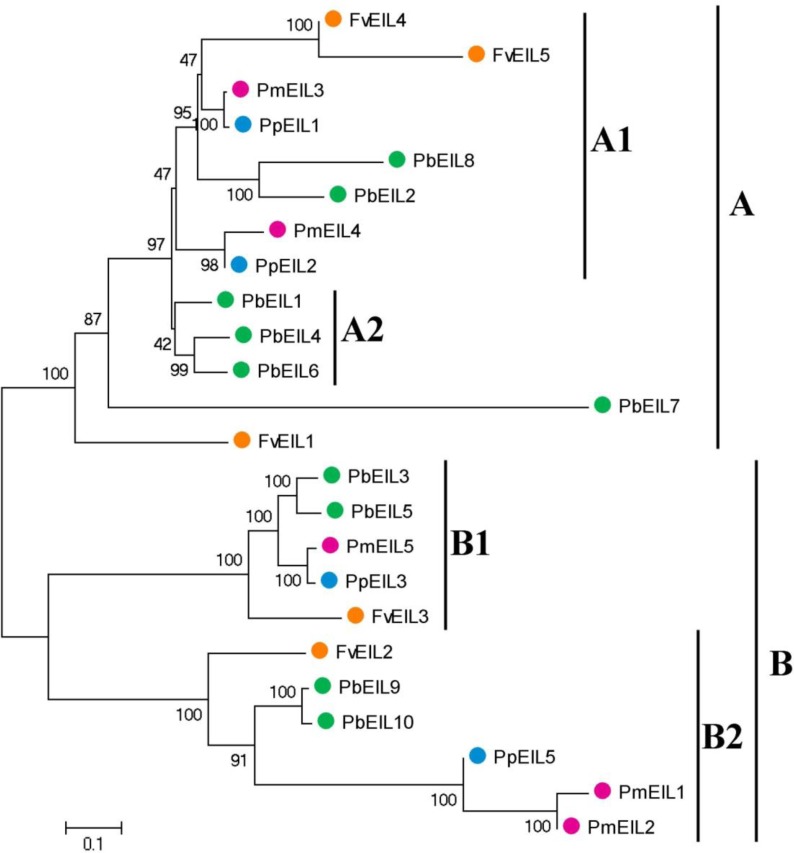
Phylogenetic tree of EIN3/EIL proteins from pear, peach, mei and strawberry.The neighbor-joining (NJ) tree was constructed by using MEGA 5 software. The neighbor-joining (NJ) tree was constructed by using MEGA 5 software (1,000 bootstrap replicates). The different colors suggest the different species background for each EIN3/EIL protein. Gene names are listed in Table 1. The scale bar represents 0.1 amino acid changes per site.